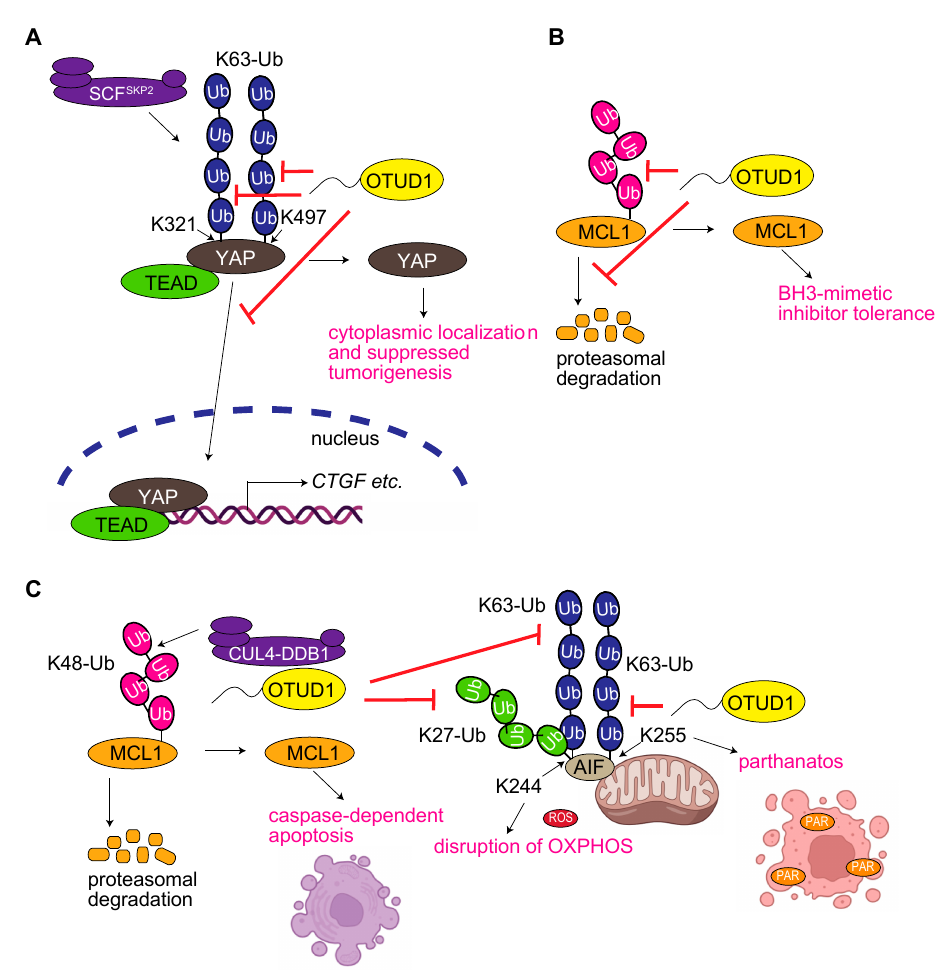
Figure 3. OTUD1 regulates YAP signaling and MCL1 degradation in tumorigenesis. ( A ) OTUD1 regulates the YAP signal [31]. ( B ) OTUD1 inhibits MCL1 degradation [35]. ( C ) OTUD1 regulates MCL1 degradation, mitochondrial AIF function, and cell death [36].